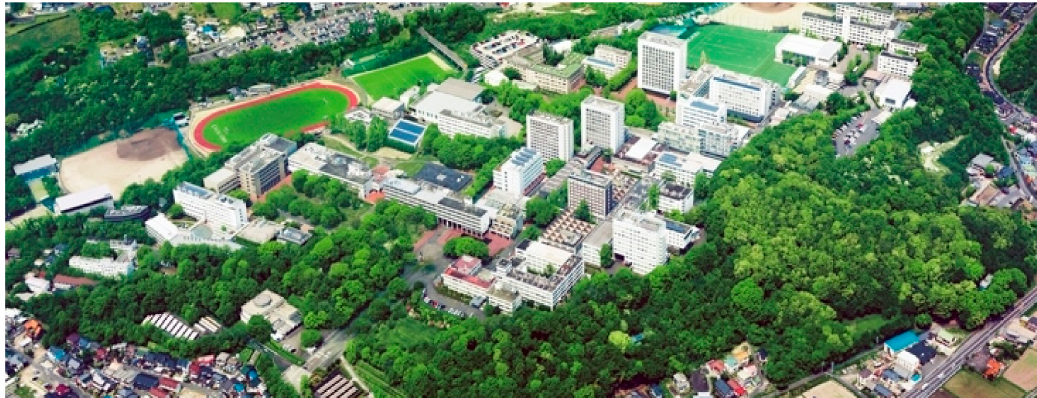
Figure 1. Aerial photograph of Chubu University,